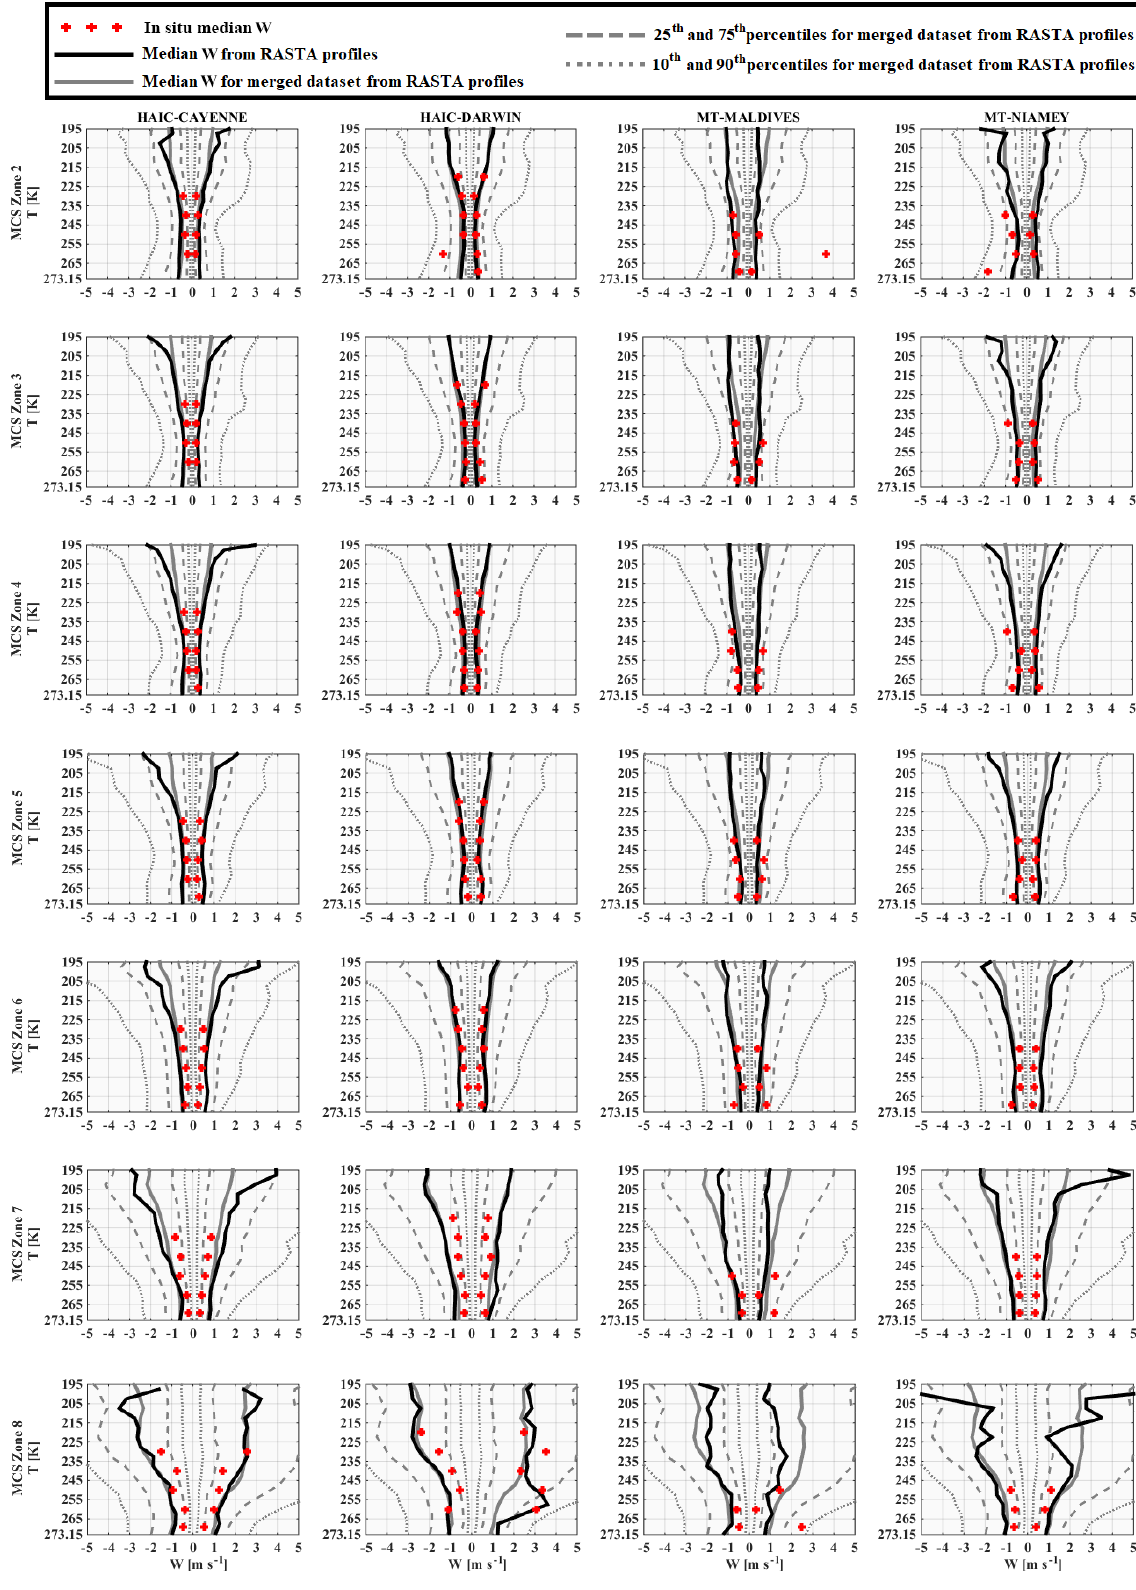
Figure 3. Vertical velocities for MCS reflectivity zone 2 to MCS reflectivity zone 8 from the top line to the bottom line,